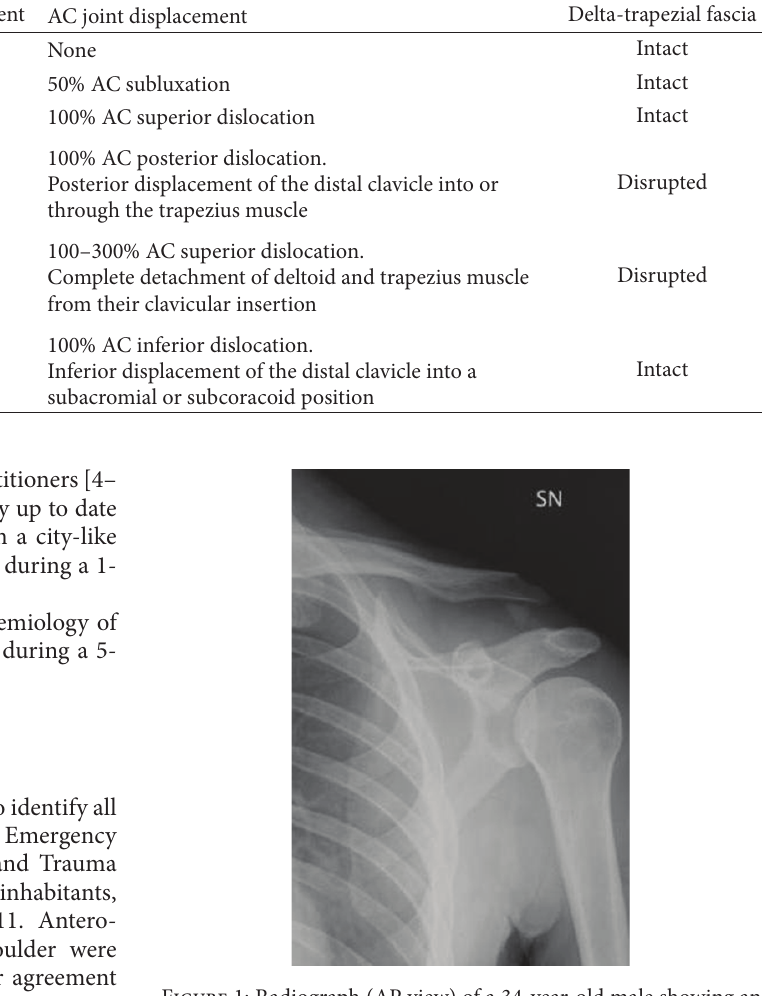
T 1: e Rockwood classi�cation takes into account not only the acromioclavicular joint, but also the coracoclavicular ligament, the deltoid and trapezius muscles , and the direction of dislocation of the clavicle with respect to the acromion. According to this classi�cation, AC dislocations can be divided into 6 types.